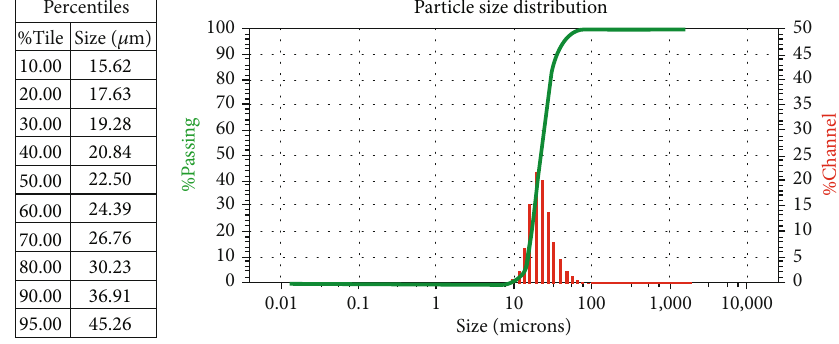
Figure 9: Particle size distribution chart of copaiba oil microcapsules.